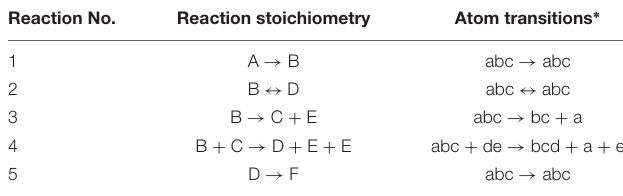
TABLE 1 | Stoichiometry and atom transitions for the reactions in the example metabolic network. Reaction